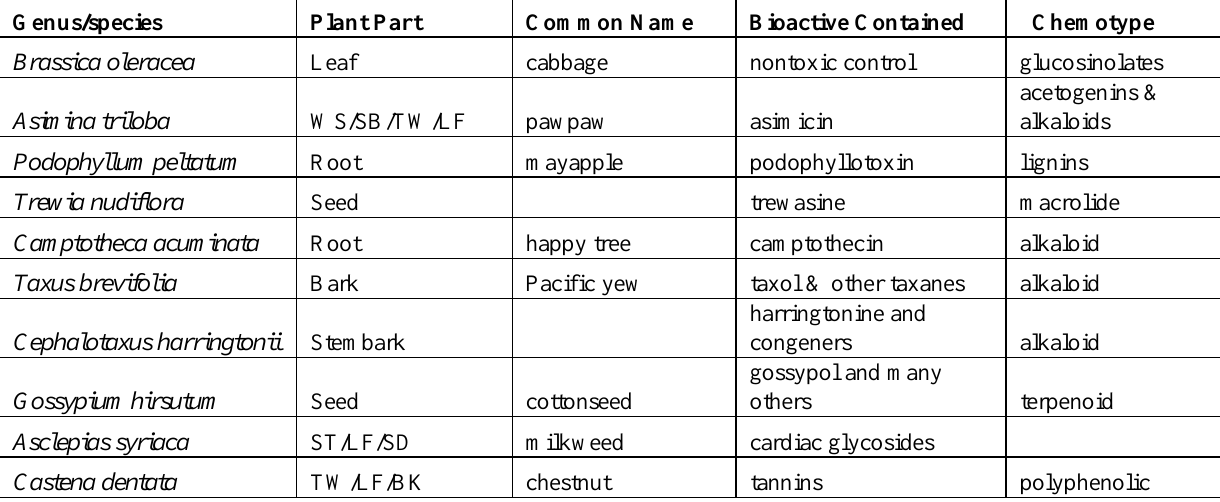
Table 3. Some Methods Development Plants and Bioactive Compounds Contained